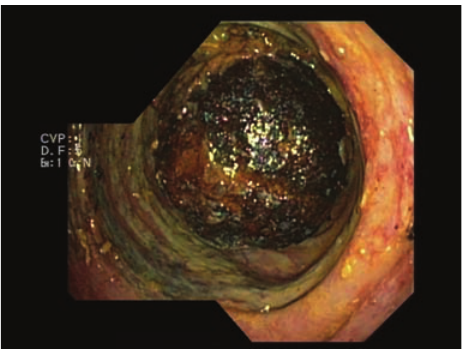
Figure 4: Endoscopic view of an obstructing and inextractable gallstone in the sigmoid